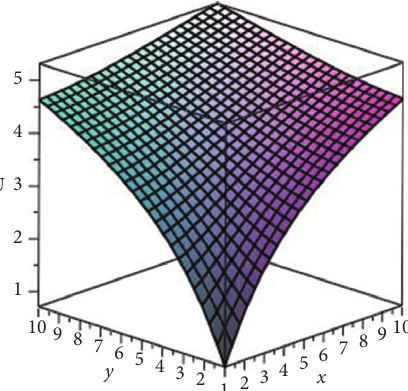
Figure 2: Graph of w given by (27) for C � 0.5, C